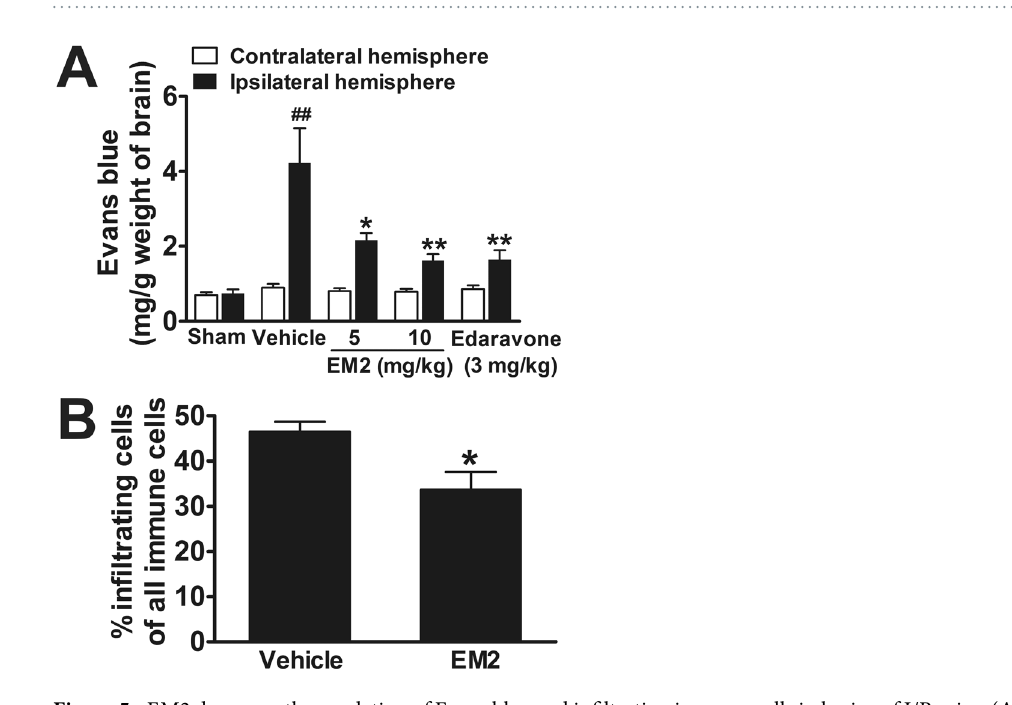
Figure 5. EM2 decreases the exudation of Evans blue and infiltrating immune cells in brains of I/R mice. ( A ) The amounts of blue dye in the hemispheres at 48 h after reperfusion were measured and compared among groups (n = 10). ( B ) Quantitative analysis of infiltrating immune cells (CD45 high + ) in the ipsilateral hemisphere following 72 h of reperfusion by flow cytometry (n = 4). All data are presented as means ± S.E.M. ## p < 0.01 compared with sham group. * p < 0.05 and ** p < 0.01 compared with vehicle